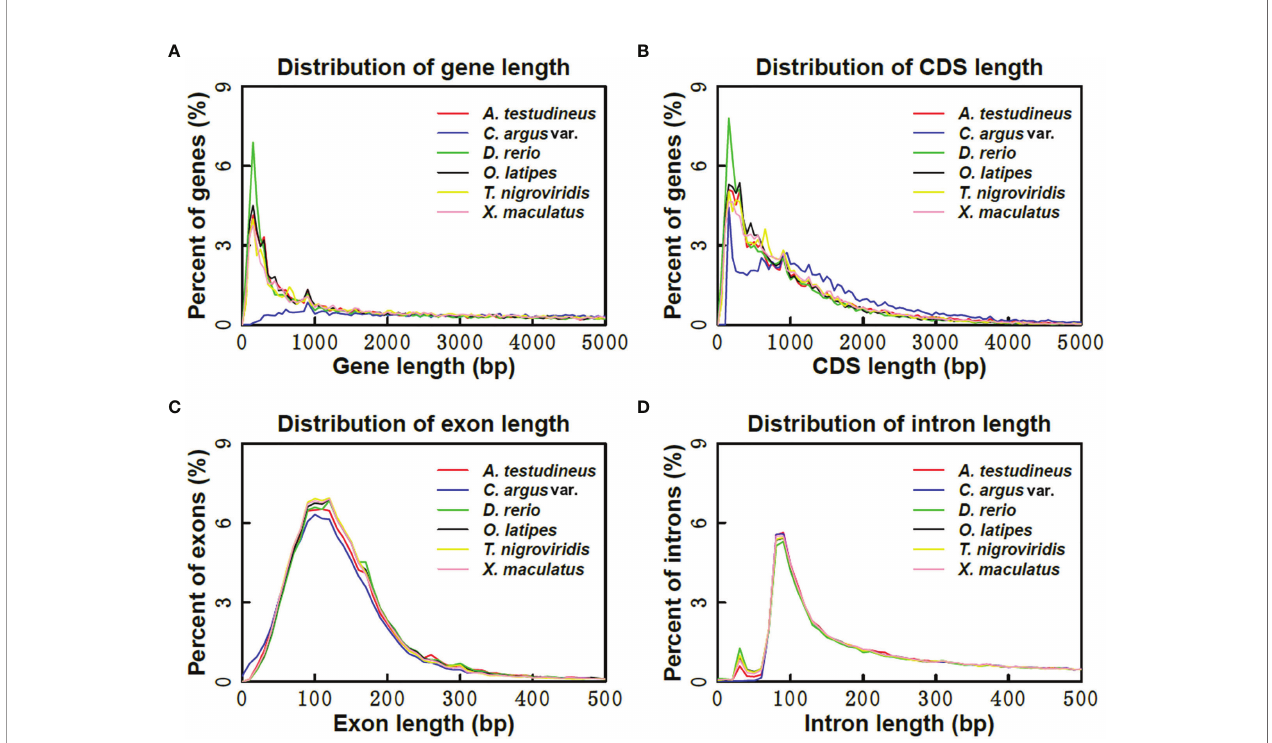
FIGURE 3 | The gene structure comparison of C. argus var. to A. testudineus (Anabas testudineus) , D. rerio , O. latipes , T. nigroviridis , and X. maculatus . (A) Gene length distribution comparison; (B) CDS length distribution comparison; (C) exon length distribution comparison; (D) intron length distribution comparison.